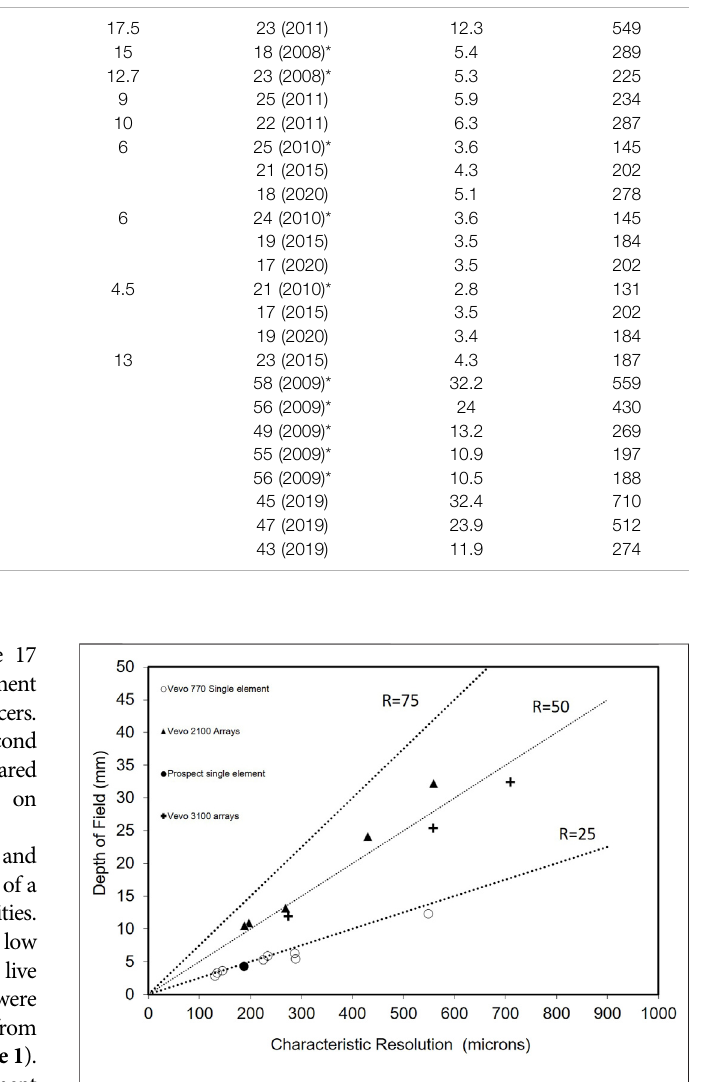
FIGURE 2 | Measured values of depth of fi eld and characteristic resolution for 17 preclinical ultrasound transducers Measurements shown are the fi rst set of measurements undertaken for each probe. Note that the gradient of a line from the origin to each of these points is equal to the resolution integral. The three lines indicate resolution integral values of 75, 50 and